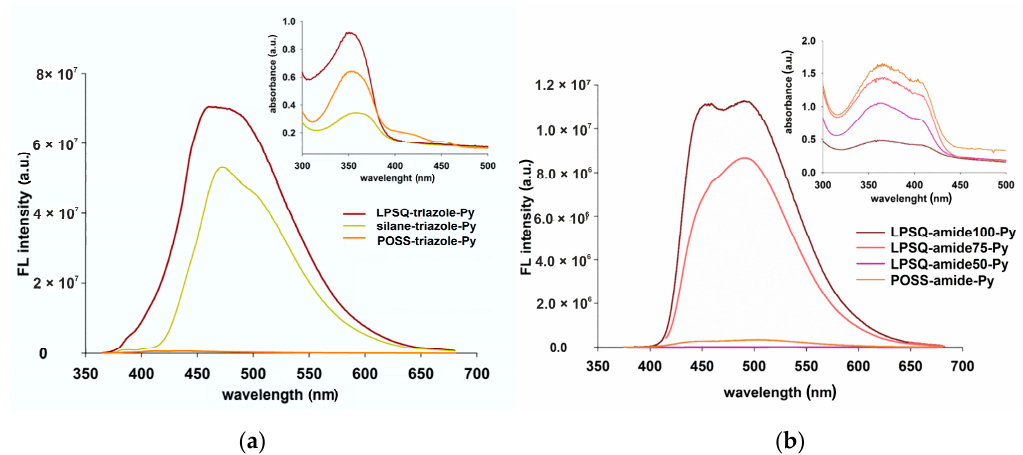
Figure 13. FL and absorption spectra for thin films of LPSQ and POSS materials containing ( a ) triazole and ( b ) amide groups in side substituents. and ( b ) amide groups in side substituents.